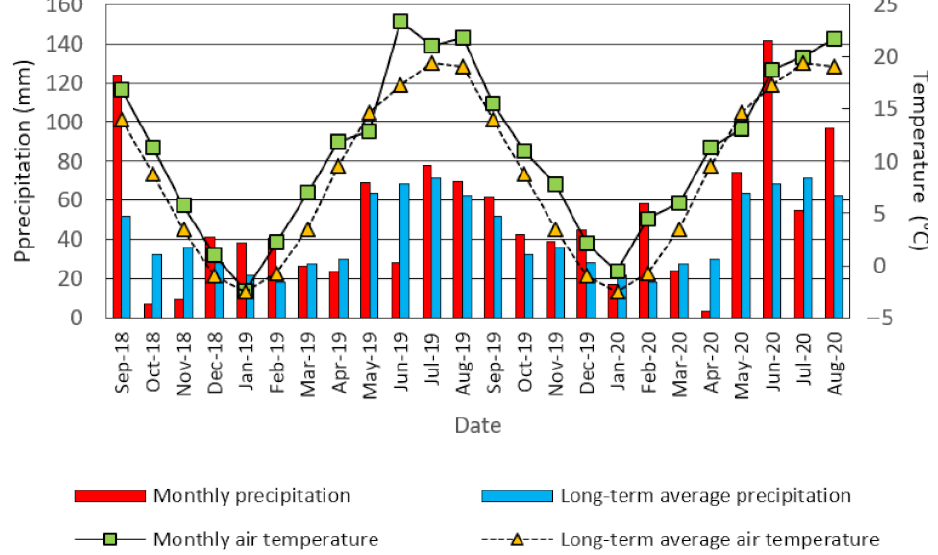
Figure 2. Monthly and long-term air temperature ( ◦ C) and precipitation (mm) at the experimental site Velk ý T ý nec in the Czech Republic during the experimental period of 2018–2020. The long-term average is from the period of